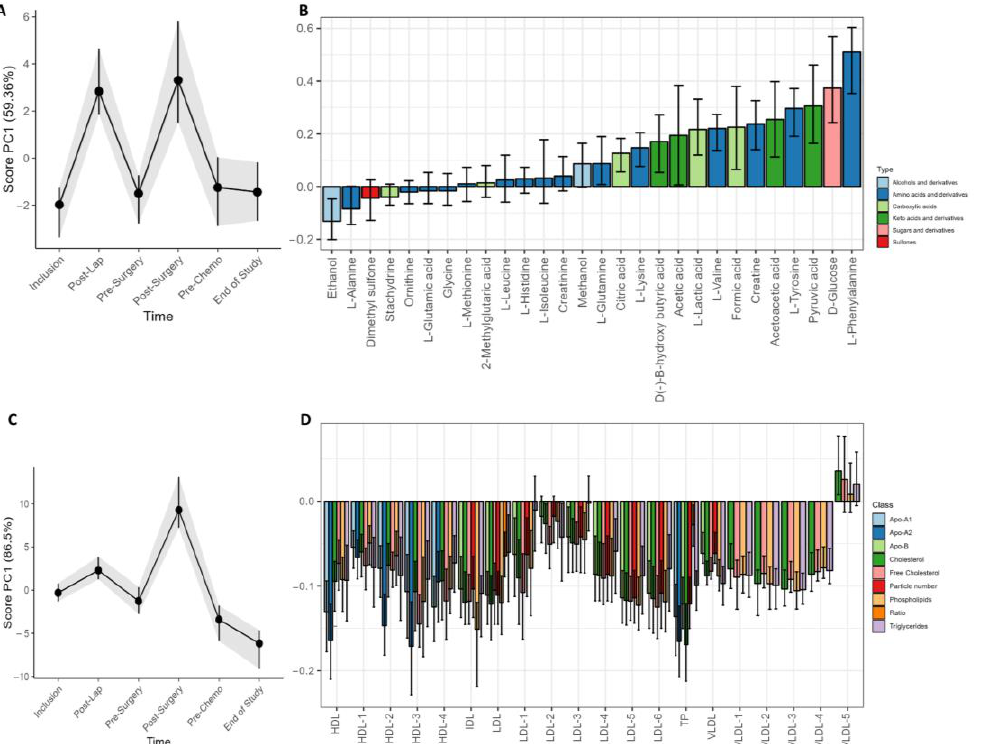
Figure 4. Longitudinal development of circulating metabolites and lipoprotein subfractions of all patients during the study period. Results show scores and loadings from RM–ASCA+ analysis for ( A ) circulating metabolites and ( C ) lipoprotein subfractions (n = 23/24). The response to increases or decreases of the trajectory lines is explained by their corresponding loading plots ( B , D ). The loading plots ( B , D ) describe the contribution of each metabolite or lipoprotein (x-axis) to their corresponding score (y-axis). The scores show the overall development of the patients over time. An increase in the PC1 score ( A , C ) indicates an increase in metabolite or lipoprotein subfractions with positive loadings and reduced negatively loaded subfractions and/or subfractions with decreasing negative loading. A decrease in PC1 score indicates a decrease in metabolite or lipoprotein subfractions with positive loadings but an increase in the subfractions with negative loadings. The 95% confidence interval is shown with black lines within the bars.